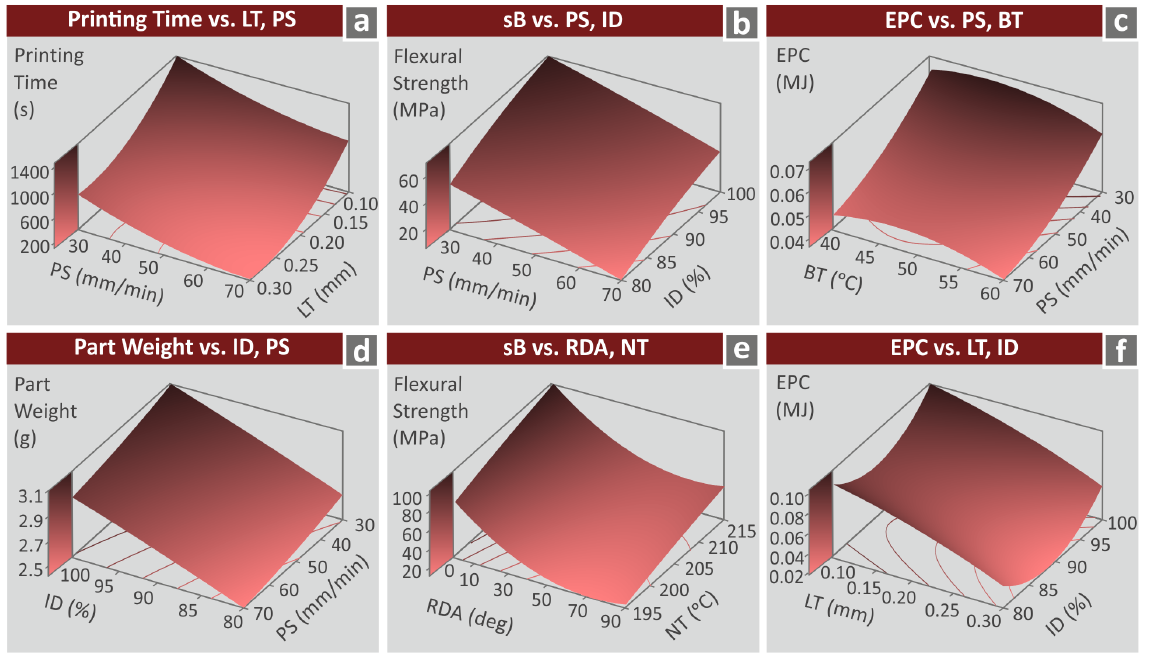
Figure 11. Pareto diagram along with a graph depicting a comparison between the experimental and the calculated values of the following metrics: ( a ) flexural strength (MPa), ( b ) EPC (MJ).